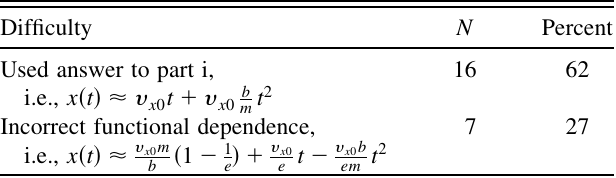
TABLE III. Difficulties constructing an expansion around a nonzero expansion point–part iii in Fig. 4(b). Percentages are of the students who had difficulty with the nonzero expansion point (65% of 40, N ¼ 26 ). Codes are not exhaustive but represent the most common themes; thus, the total N in the table need not sum to